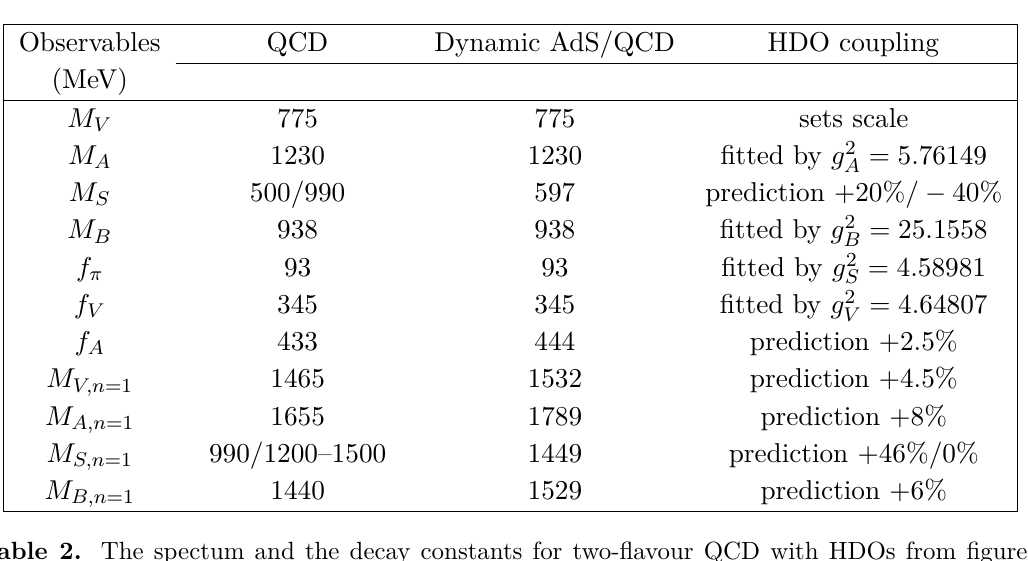
Table 2. The spectum and the decay constants for two-flavour QCD with HDOs from figure 7 used to improve the